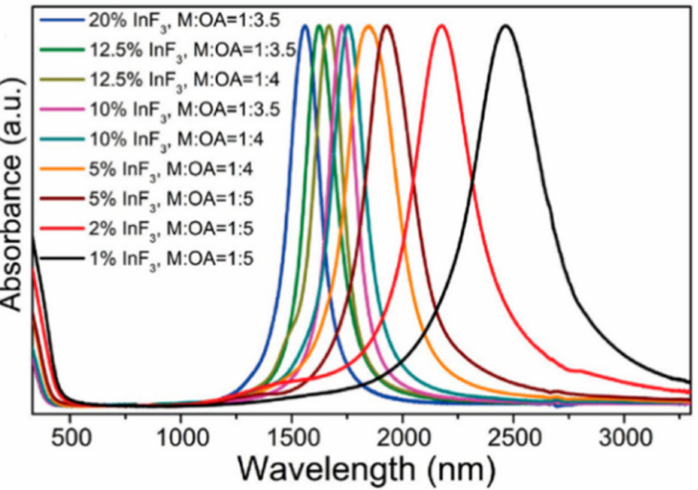
Figure 13. UV-VIS-NIR spectra of spherical FICO NCs dispersed in CCl 4 . Reproduced with permis- sion from